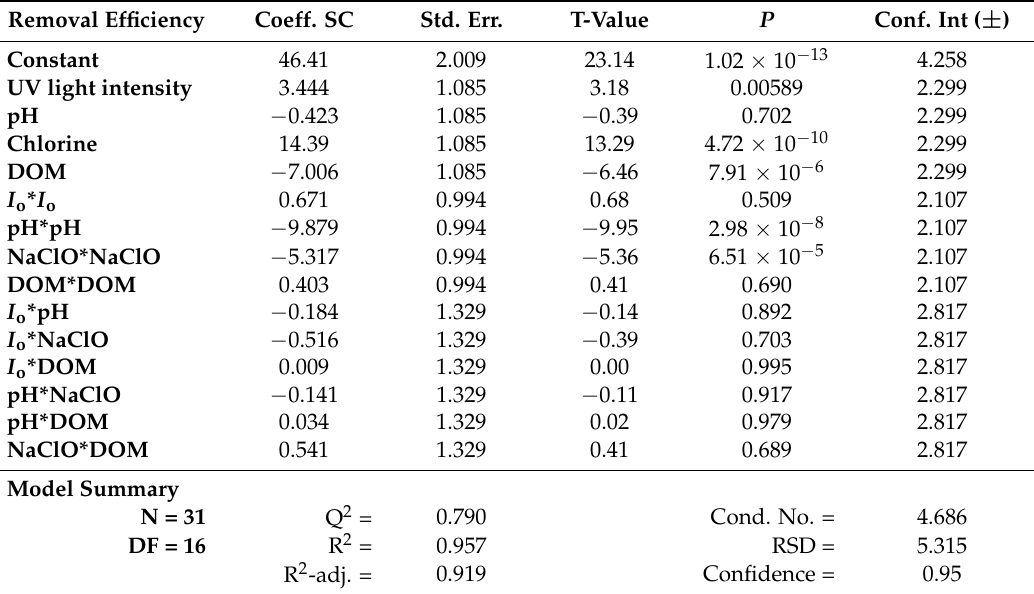
Table 3. Regression coefficients values (coded variables) of the polynomial model of responses for removal efficiency of PRC after 10 min.